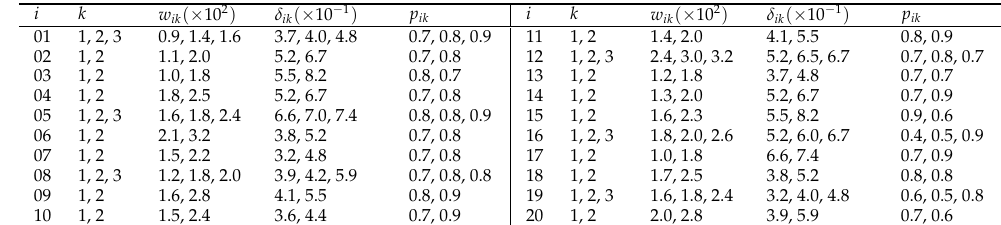
Table 2. Demand points